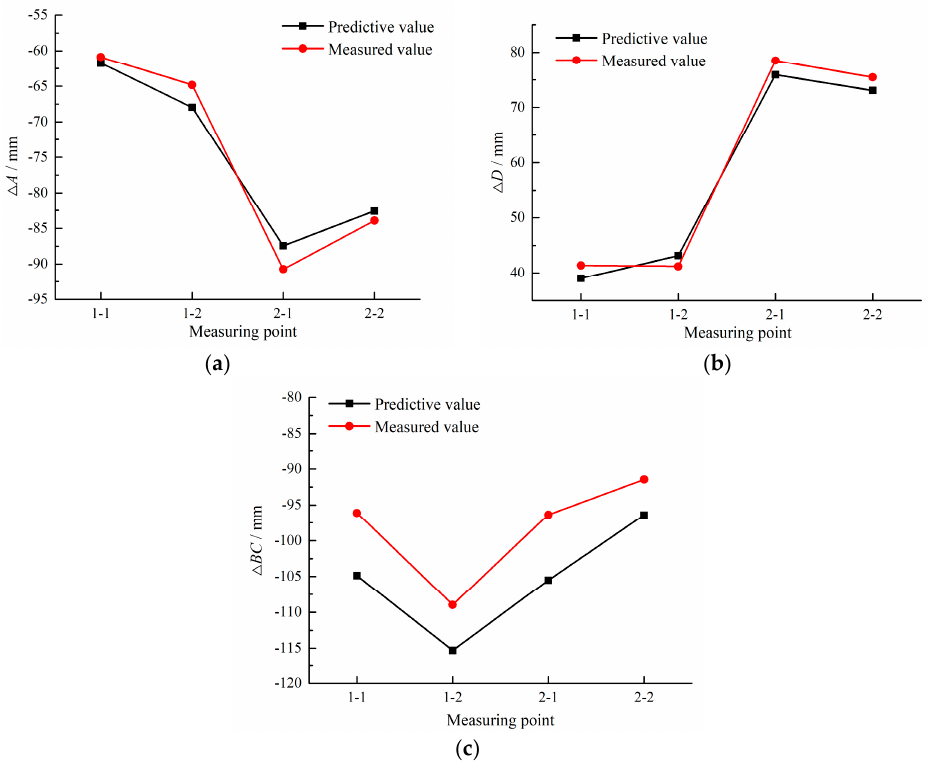
Figure 11. Comparison of surrounding rock deformation results. ( a ) the displacement of ∆ A. ( b ) the displacement of ∆ D. ( c ) the displacement of ∆ BC.